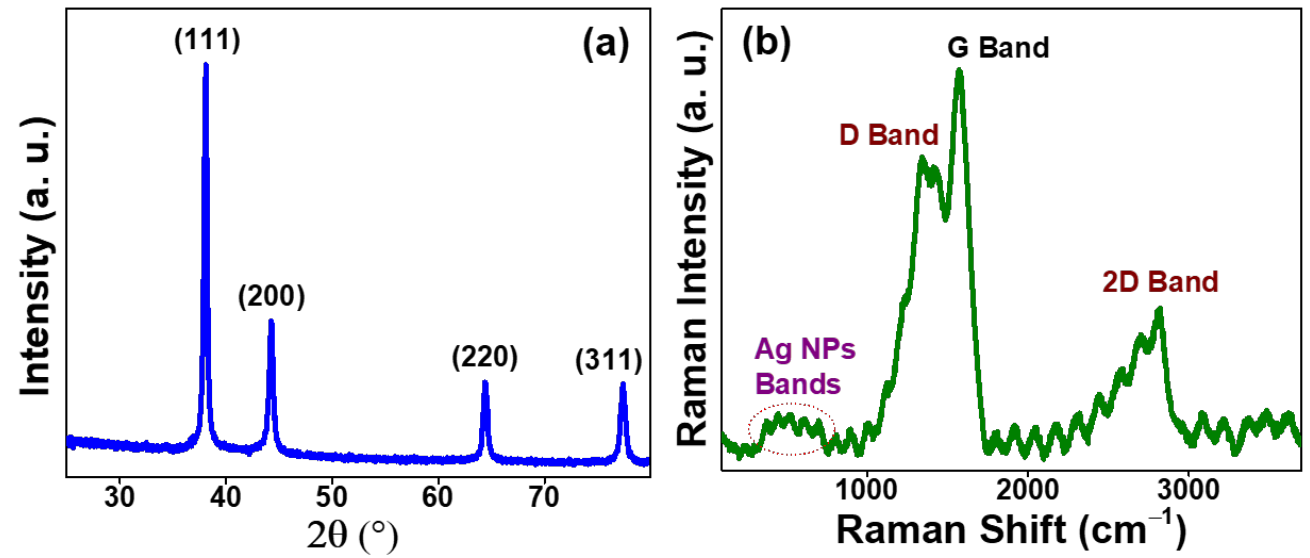
Figure 1. ( a ) XRD pattern and ( b ) Raman spectrum of the synthesized CDs@AgNPs.